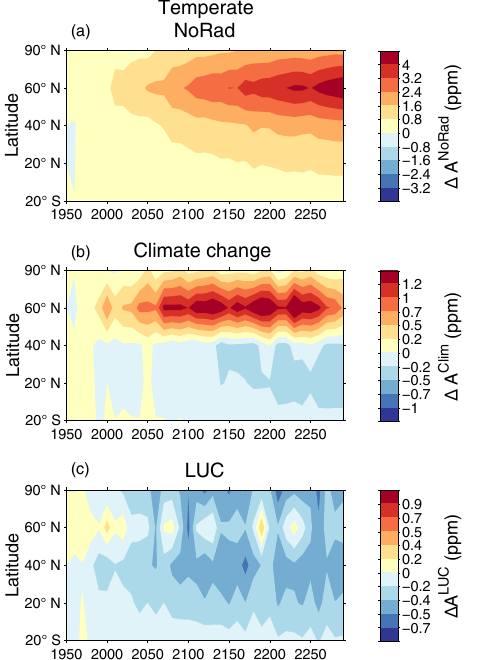
Figure 10. As in Fig. 8 but for (a) CO 2 fertilization + N deposition, (b) climate change, and (c) LUC from NH temperate regions. Note that the color scales are different in each panel.